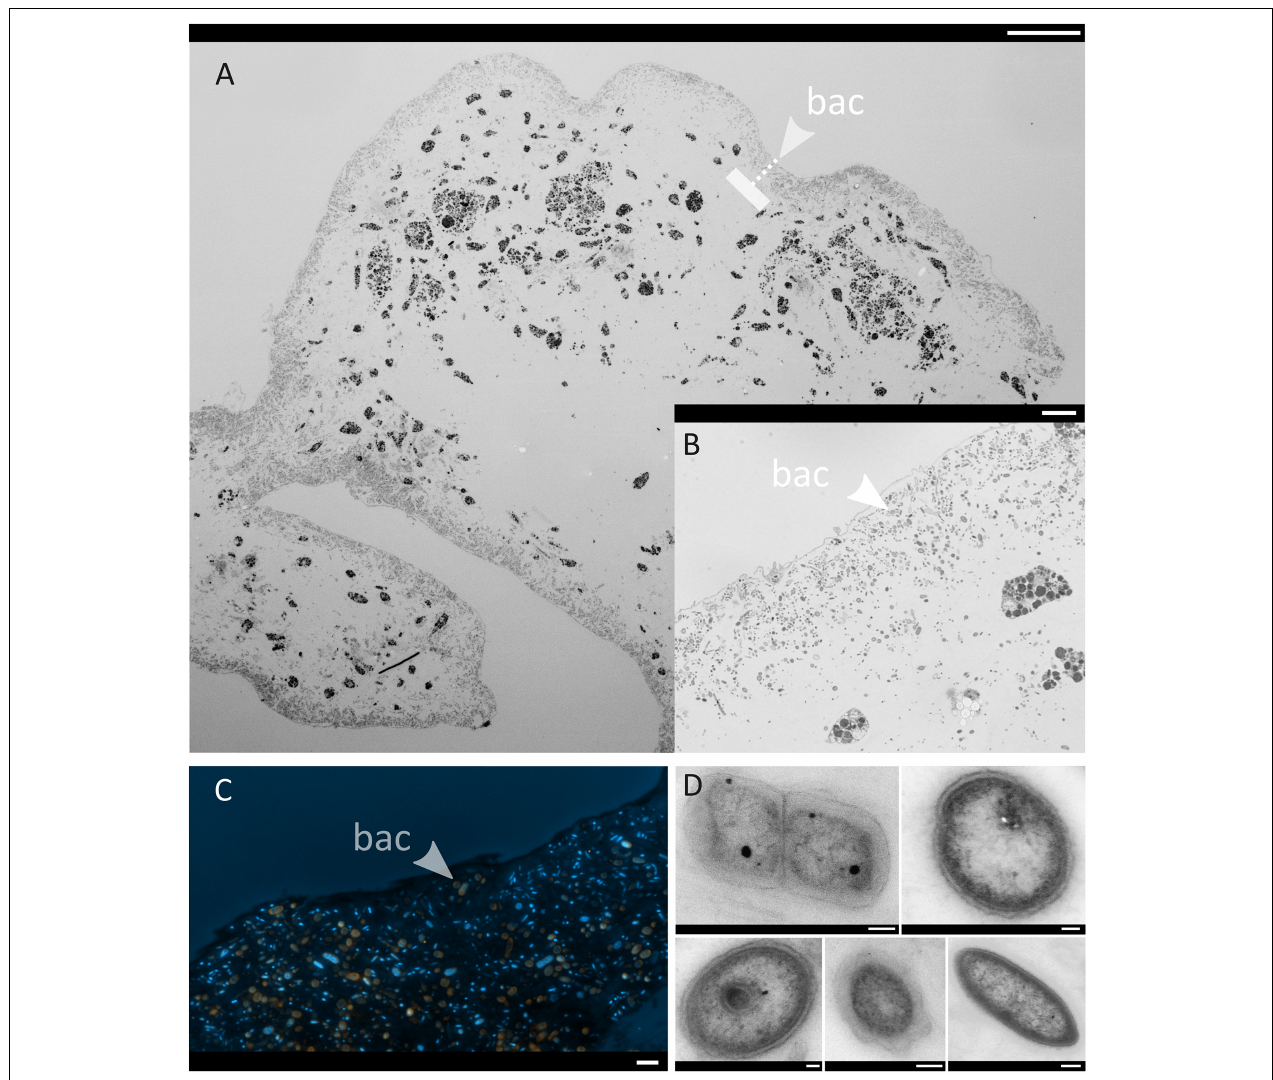
FIGURE 7 | Micrographs of one representative C . infrequens embryo ( n = 3 inspected). Arrows point from the outside to the inside. bac = band of bacterial cells (A) A whole C . infrequens embryo stained with Richardson solution. Scale bar = 100 µ m. The dashed line indicates the band with highest bacterial densities (B) Brightfield microscopy of the bacterial band, scale bar = 10 µ m. (C) Fluorescence in situ hybridization of the bacterial band. Merged channels of SAR202 signals (orange) and the DAPI counter stain (blue) are shown, scale bar = 2 µ m. Micrographs of isolated hybridization signals for the specific probes ( Anaerolinae , Caldilineae , and SAR202 ) are included in Supplementary Figures S5A–D . (D) TEM close-up of microbial cells located within the bacterial band, scale bars = 200